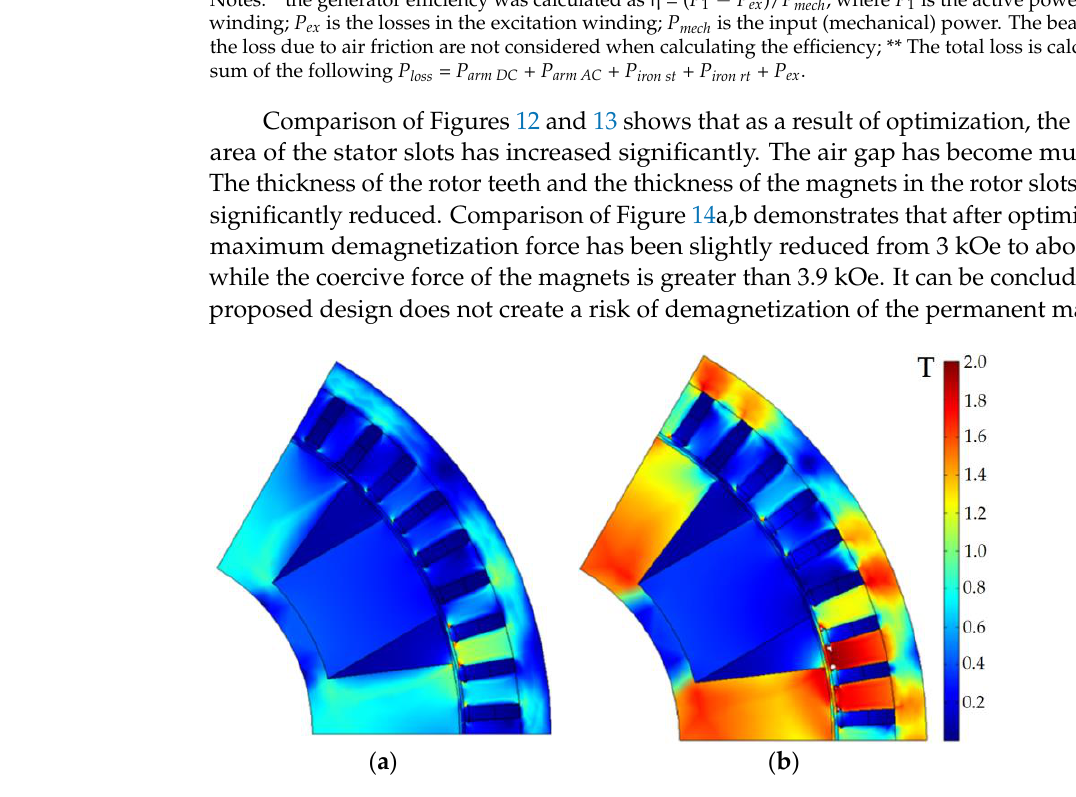
Figure 10. Change of the generator parameters during optimization: ( a ) Nonsymmetrized torque ripple; ( b ) Symmetrized (output) torque ripple.